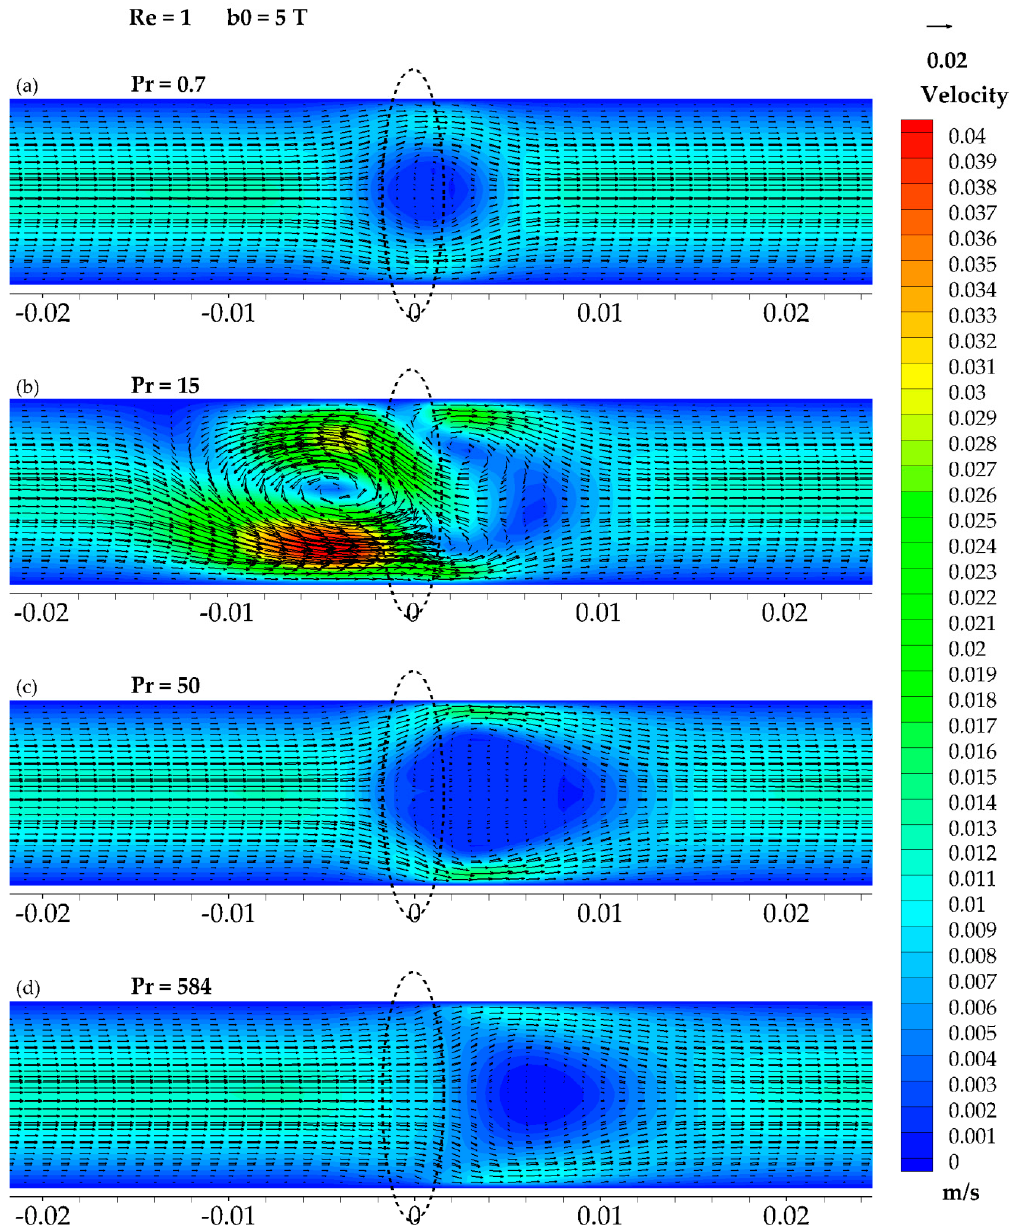
Figure 6. Flow structure in the axial cross-section at Re = 1 and b 0 = 5 T: ( a ) Pr = 0.7, ( b ) Pr = 15, ( c ) Pr = 50, ( d ) Pr = 584.